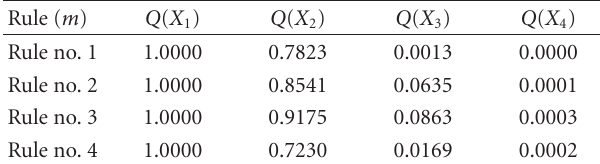
Table 12: Estimated Q